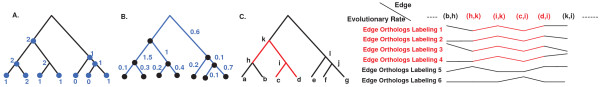
A. A hypothetic example of a node orthologous labeling which includes gene copy number in each node of the evolutionary tree. B. A hypothetic example of an edge orthologous labeling which includes dN/dS along each edge of the evolutionary tree. C. The goal of the local co-evolutionary problem is to find large sets of orthologs that have similar patterns of evolution across large subtrees of the evolutionary tree.